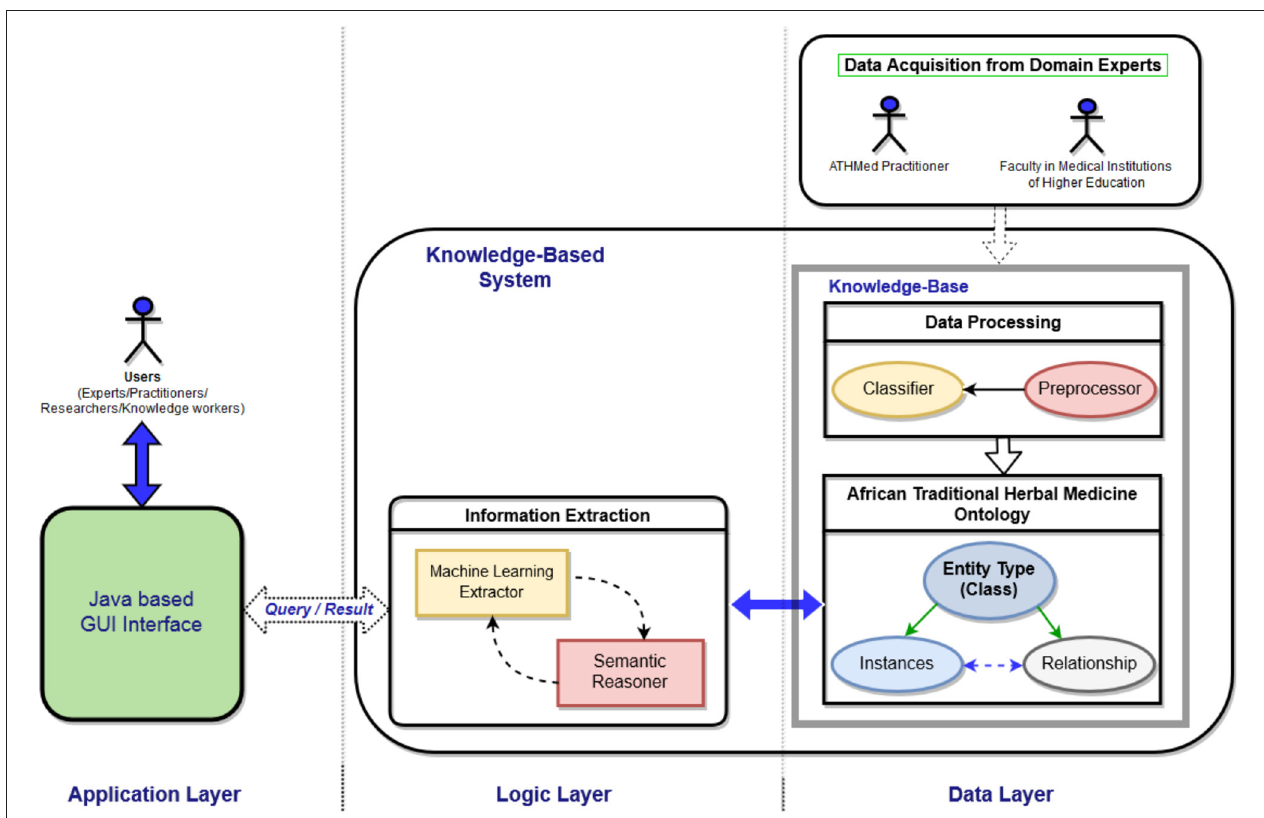
FIGURE 2 | Proposed Knowledge-based Design framework for African traditional herbal medicine (Devine et al., 2019).